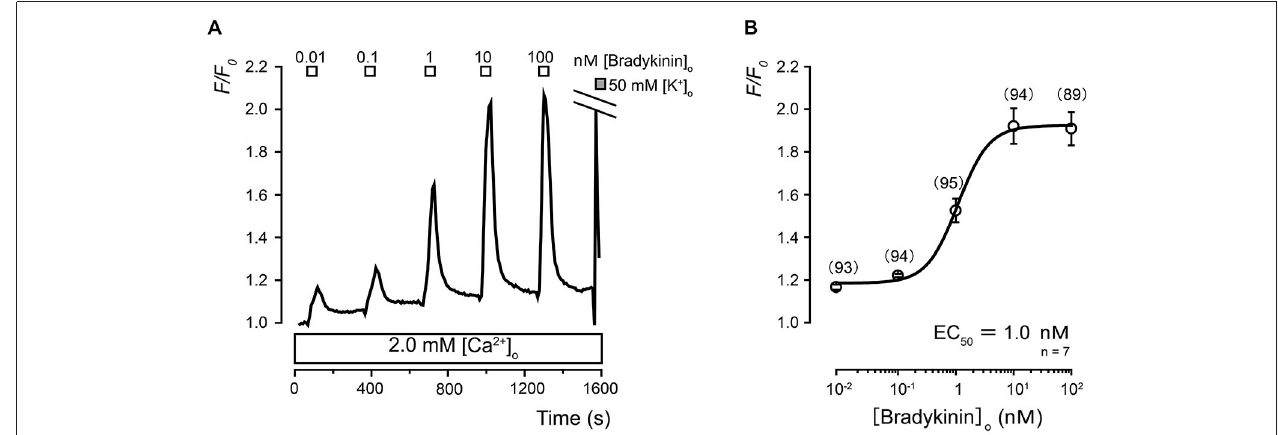
parentheses represent the number of tested cells). The curve on the semilogarithmic scale was fitted according to Equation 1 , which is described in the text. The upper gray box in (A) indicates the timing of the application of the 50 mM KCl solution. The equilibrium binding constant of BK